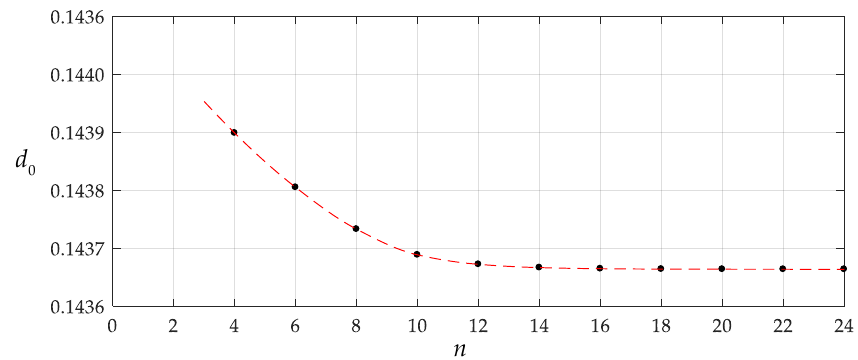
Figure 5. Variation of c 0 with n .